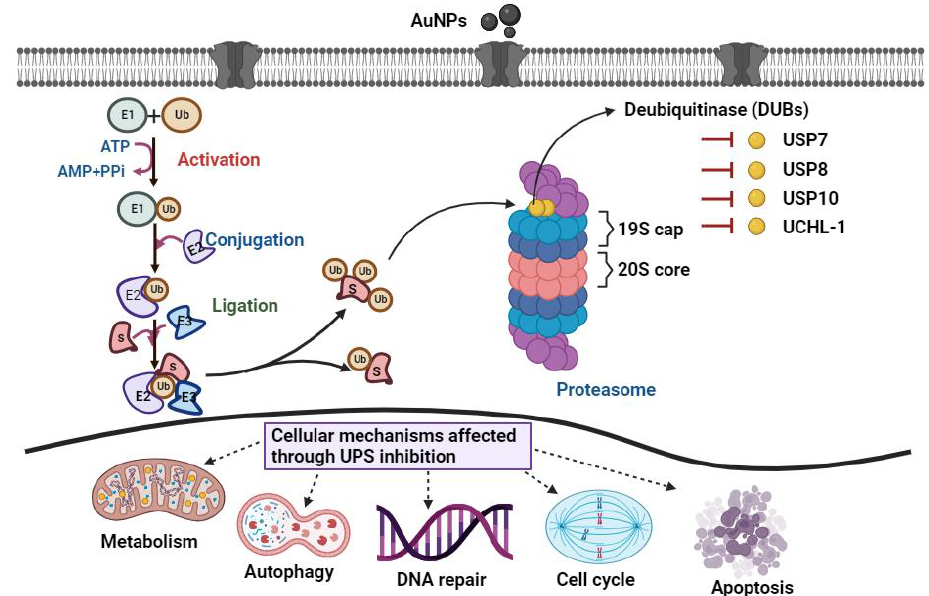
Scheme 1. UPS diagram. Ubiquitin-activating enzymes (E1) activate the first step of the process which forms a thioester bond in the presence of a higher energy compound (ATP). The activated ubiquitin is then transferred to the ubiquitin conjugation enzyme (E2) via a transthiolation reaction. Ubiquitin ligases (E3) provide substrate specificity for the reaction and catalyse the covalent binding of ubiq- uitin to the target substrate through an isopeptide bond. The polyubiquitinated substrate moves to the proteasome for degradation. Finally, DUBs associated with the 19S proteasome remove conju- gated ubiquitin from the substrate prior to the degradation. Supplementary Materials: The following supporting information can be downloaded at: www.mdpi.com/xxx/s1. Figure S1: TEM images of different sizes AuNPs; Figure S2: Dot plots of the side scatted intensity (SSC) versus forward scattered intensity (FSC) of A549 cells treated with dif- ferent concentrations of AuNPs for 24 h; Figure S3: Percentage cell viability of A549 cells pre-treated with pharmacological inhibitors determined using MTT assay; Figure S4: Dot plot effects of phar- macological inhibitors on the internalisation of different sizes AuNPs in A549 cells; Figure S5: Apop- tosis and necrosis analysis of A549 cells following the exposure to AuNPs of different sizes using flow cytometry at of 5 – 30 µg/mL for 24 h; Table S1: Surface area (m 2 /g) of different 5, 10, and 80 nm AuNPs at different mass concentrations used in the cell viability assays; Table S2: Table showing the number of particles per volume (NPs/ML) for the highest concentration used in the cell viability assay and the number of viable cells remaining after exposed to different sizes of AuNPs for 24 h. Author Contributions: B.I.: Conceptualisation, Methodology, Validation, Investigation, Formal analysis, Writing, Visualisation, Editing. T.H.A.: Methodology, Visualisation, Formal Analysis, S.C.: Methodology, Formal Analysis, Writing, Visualisation, Editing, H.A.-B.: Conceptualisation, Meth- odology, Validation, Visualisation, Editing E.V.-J.: Conceptualisation, Visualisation, Editing. All au- thors have read and agreed to the published version of the manuscript. Funding: This research received no external funding Data Availability Statement: All the data presented here are available on request from the corre- sponding authors. Acknowledgments: B.I. thanks the Petroleum Technology Development Fund (PTDF) for the spon- sorship (PTDF/ED/PHD/IB/1394/18). Conflicts of Interest: The authors declare no conflicts of interest. References